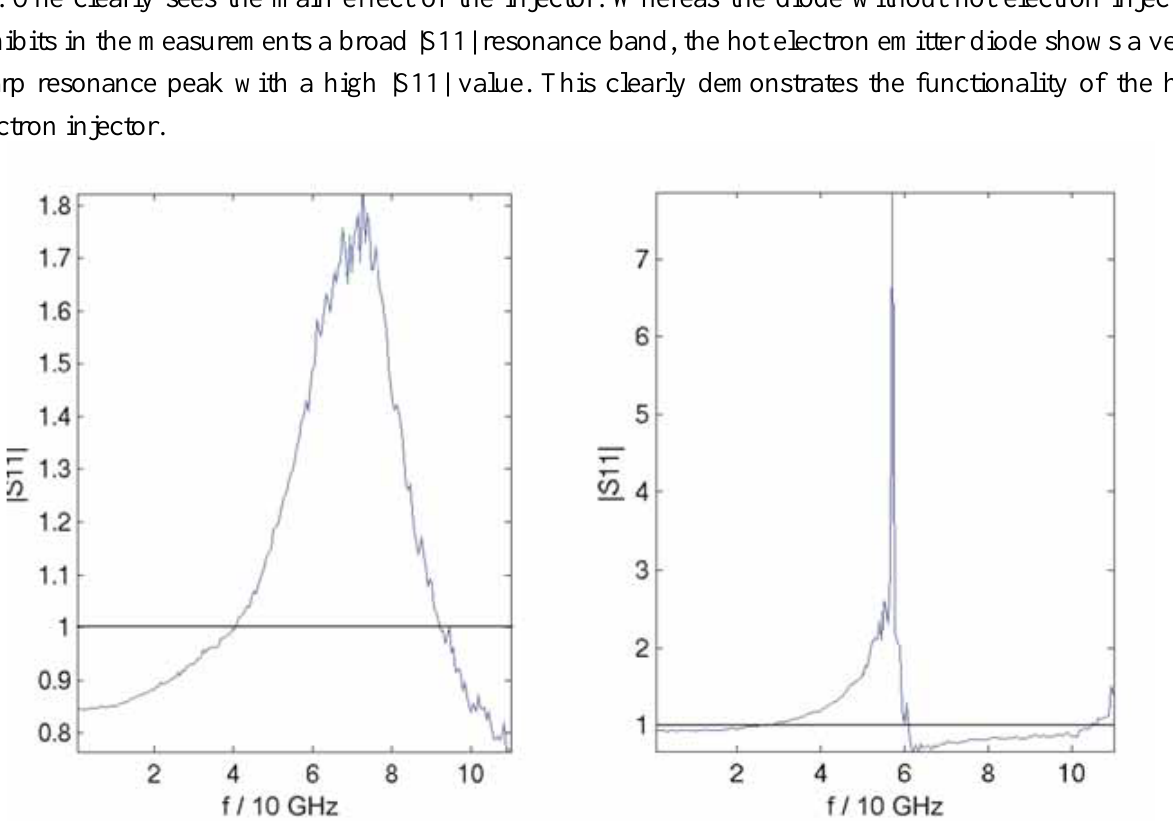
Figure 11. One port S-parameter measurements of the Gunn diode up to 110 GHz: without hot electron injector (left), and with hot electron injector